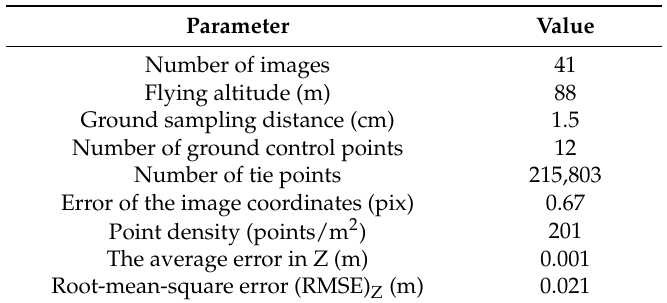
Figure 3. Unmanned aerial system (UAS) imaging and data processing. ( a ) UAS platform Mikrokopter Hexa with Canon 500D camera in the study area; ( b ) aligned imagery with ground control points (GCPs) distributed over the study area. Table 1. Parameters of the imagery and photogrammetric processing.